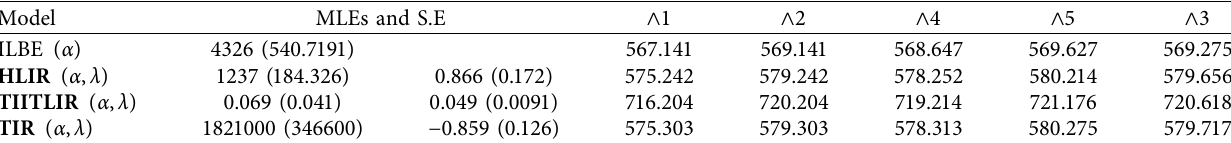
Table 5: Numerical results of MLE, SE, ∧ 1 , ∧ 2 , ∧ 3 , ∧ 4, and ∧ 5 for the third